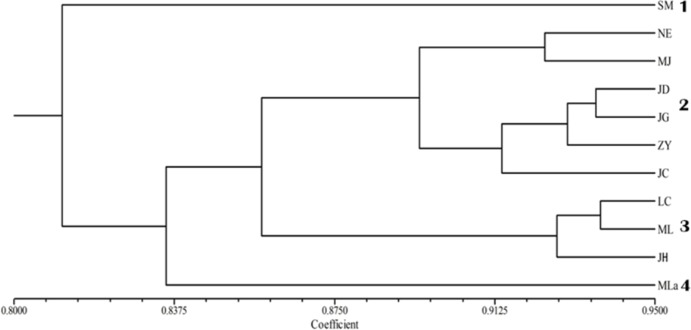
UPGMA cluster analysis of genetic similarity of 11 populations.